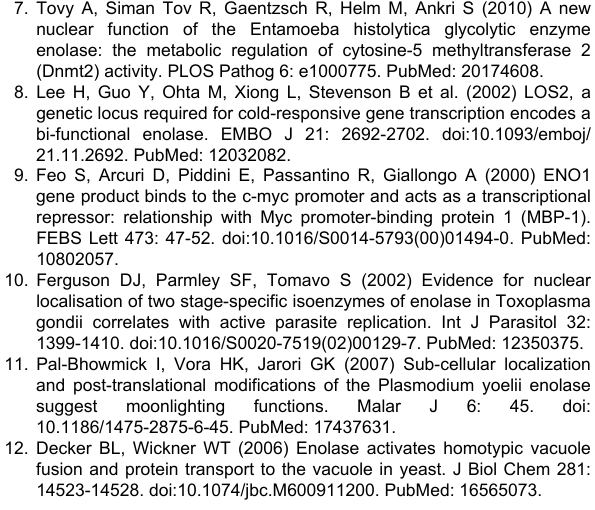
Figure S7. Comparison of PTMs in human ENO1 and Pyeno.